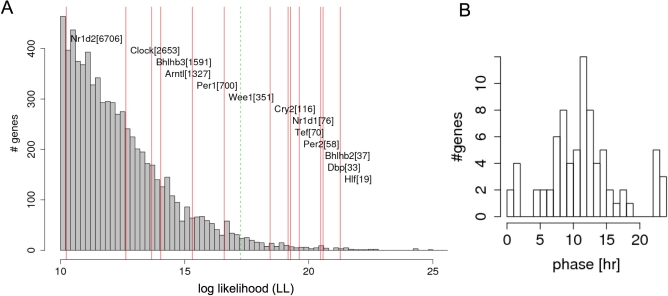
Genome-Wide Scan of the Drosophila E1-E2 Model onto the Mouse Genome(A) Genome-wide rankings of circadian mouse genes in function of their sequence likelihood score.The E1-E2 chained matrices are scanned along all mouse genes including ±2 kb flanking sequence (Methods). Only hits with average PhastCons scores above 0.5 are counted (in PhastCons 0 implies no conservation and 1 maximal conservation). The unconstrained result is shown in Figure S8. The name of the gene is always aligned to the right of its score line (in red), and its rank is indicated in brackets. A total of 7 of 13 expected circadian genes (Methods) are found above the 1% line (green dashed line), while we expected zero at this cutoff (p < 10−12). Notice Wee1 is just below the 1% line; E1-E2 is in the 3' region for this gene (Figure S7). Known circadian genes represented are Cry1, Cry2, Per1, Per2, Per3, Dbp, Tef, Hlf, Wee1, Bhlhb2 (Dec1), Bhlhb3 (Dec2), Nr1d1 (RevErbα), Nr1d2 (RevErbβ), Arntl (Bmal1), and Clock. The latter two are expressed in anti-phase with respect to known target and are mainly controlled by Ror orphan receptors and their repressors RevErbα,β [70]. Thus, Clock and Bmal1 are not included in the test set.(B) Phase distribution of all conserved hits (as in [A]) with scores above 15 bits, and which show cycling in the liver in [54] (Fourier component F24 > 0.1; Methods).